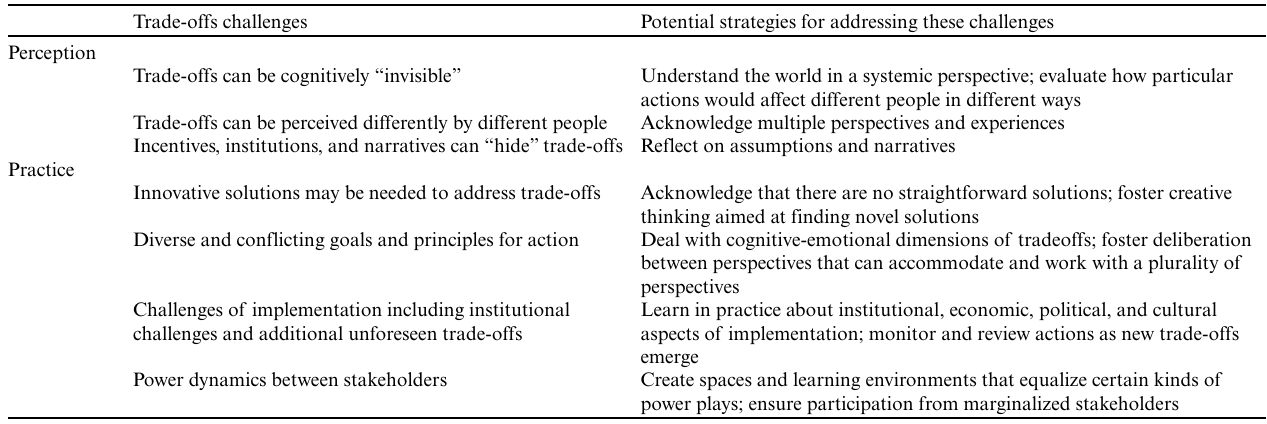
Table 1 . Trade-offs challenges and potential strategies for addressing